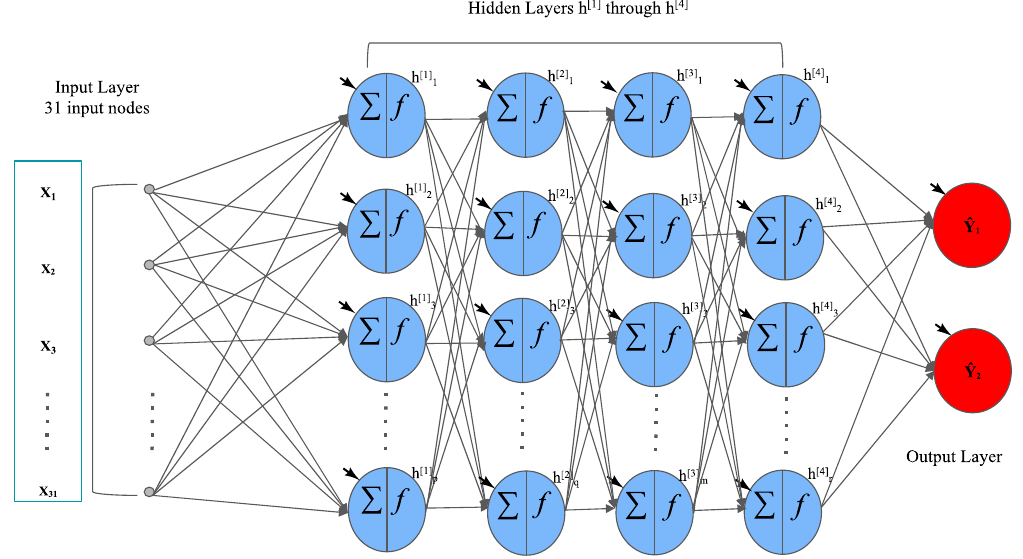
Figure 3. The structure of an FNN model that we developed.